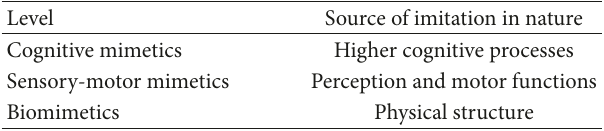
Table 1: A three-level conceptual model of design